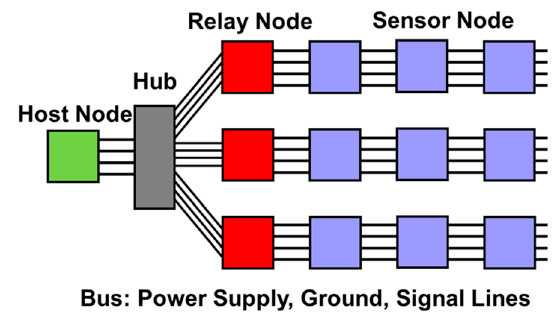
Figure 2. Nerve-net tactile sensing systems.